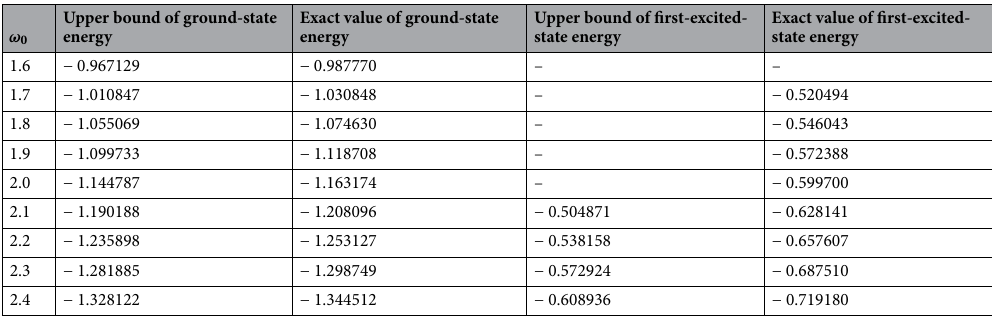
Table 1. Energies of the ground state and first excited state for different values of the model parameter ω 0 are